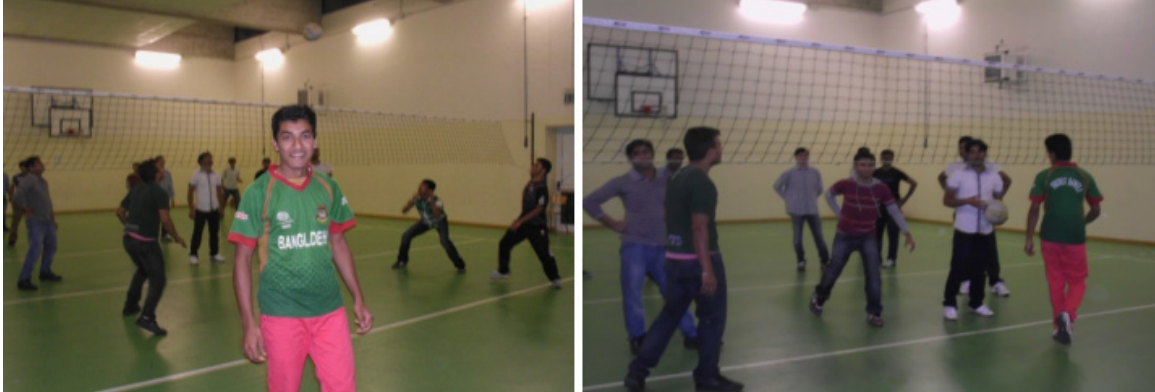
Figure 4. Bangladeshi youth playing at the ‘ Via-Rigotti 03’, Cadoneghe, Padova. Source: Fieldwork (2013).